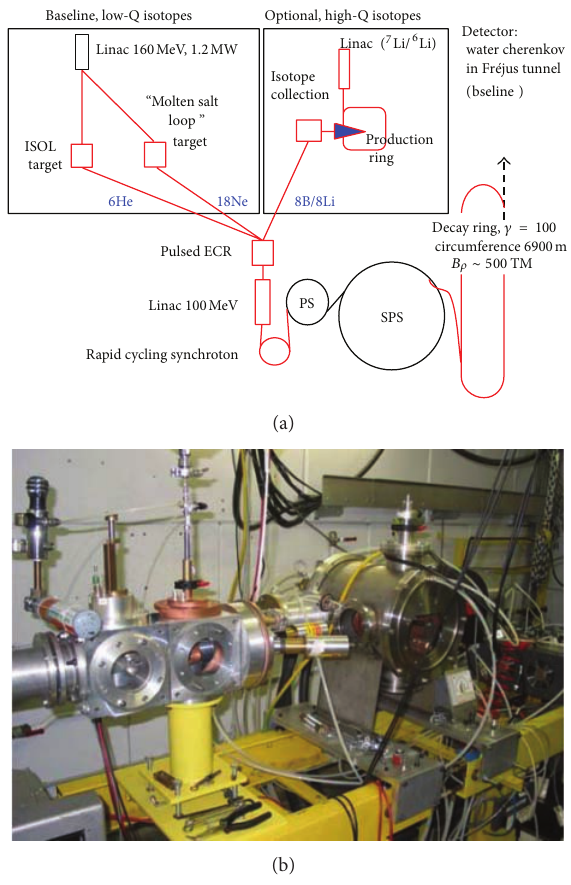
Figure 21: (a) Layout of the CERN Beta Beam. (b) The prototype ion collection device constructed for Beta Beam